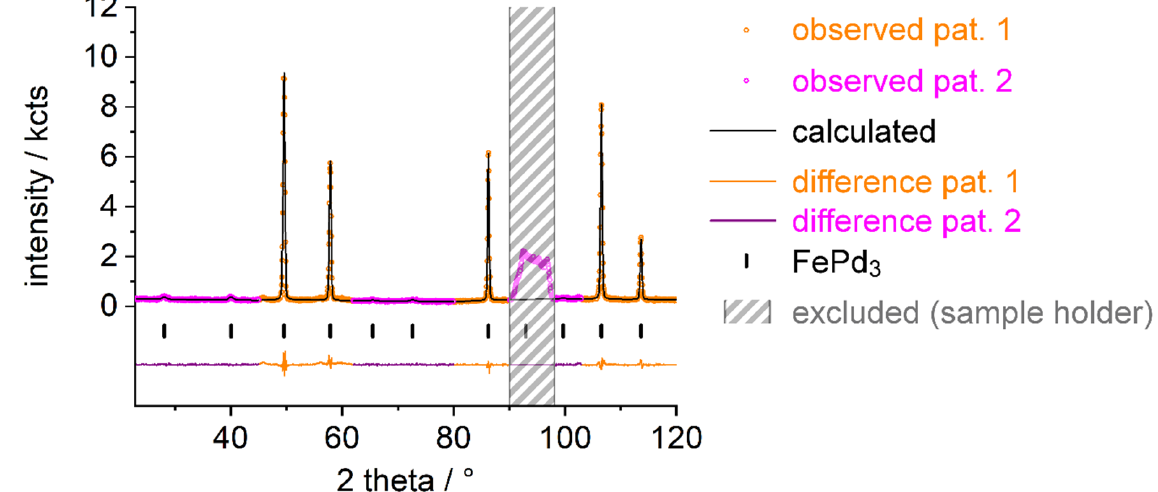
Figure A21. Rietveld refinement of the crystal structure of FePd 3 D 0.067(10) (for details, see ninth row in Tables A8 and A9) based on neutron powder diffraction data (NUMOR 131783 [21], λ = 186.80(2) pm, D20 ILL, Grenoble) in a single-crystal sapphire cell at 490(3) K and 8.22(1) MPa deuterium pressure using FullProf [24].